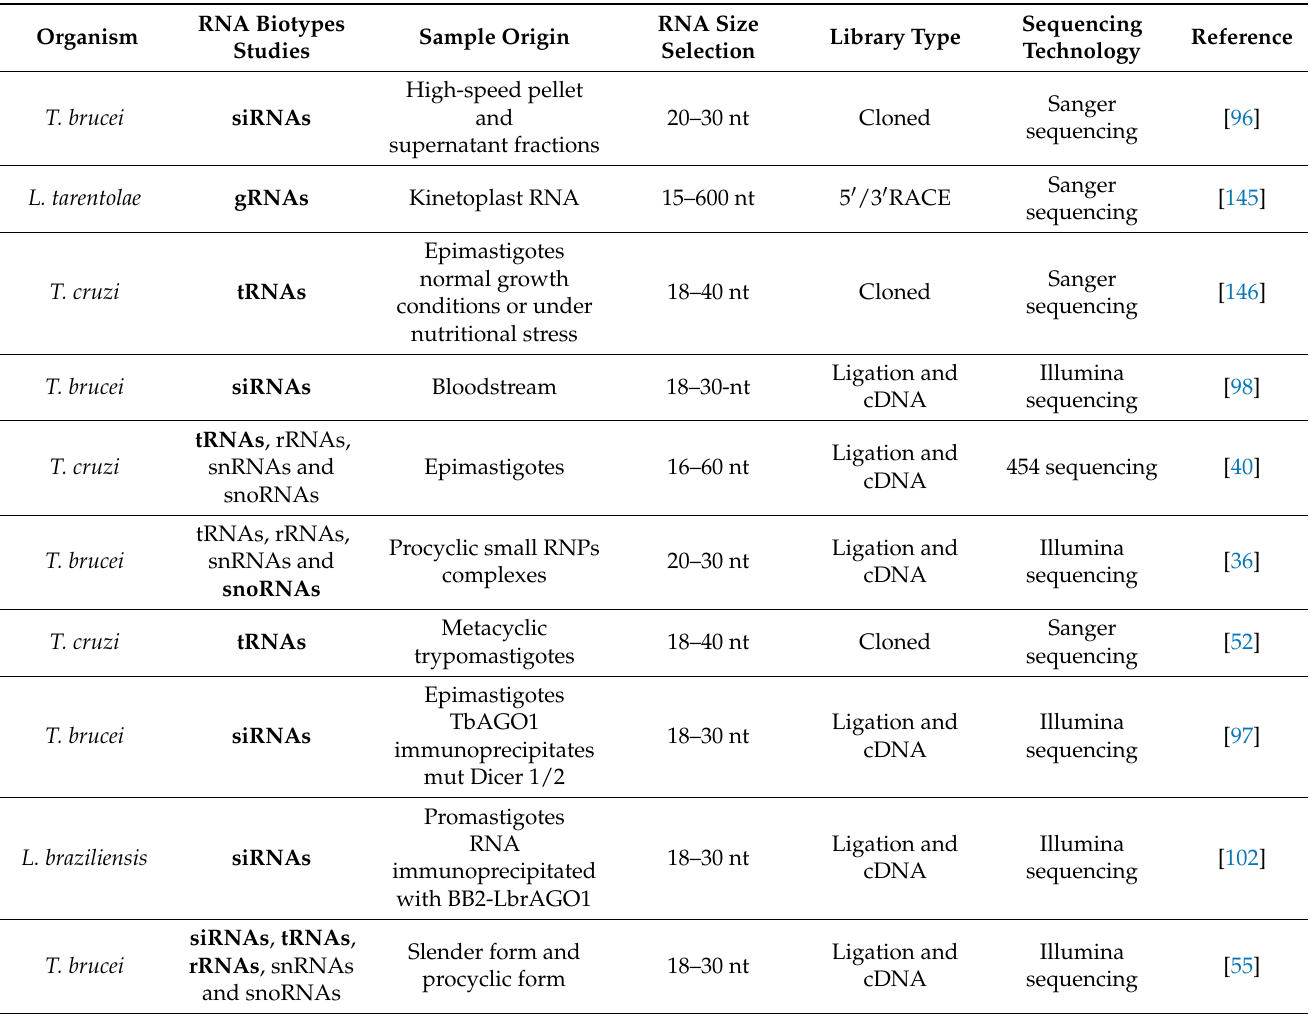
Table 2. Small RNA transcriptomic studies in Trypanosomes. RNA-sequencing studies that quantify endogenous small RNA fragments (produced without fragmentation steps in the library protocol) are included. RNA biotypes identified in the manuscript are listed and the mainly focused ones are highlighted in bold letters. The 5 ´ /3 ´ -RNA end modifications described in the library preparation are presented in parenthesis. PNK —T4 Polynucleotide Kinase, CIP —Calf Intestinal Phosphatase, TAP —tobacco acid